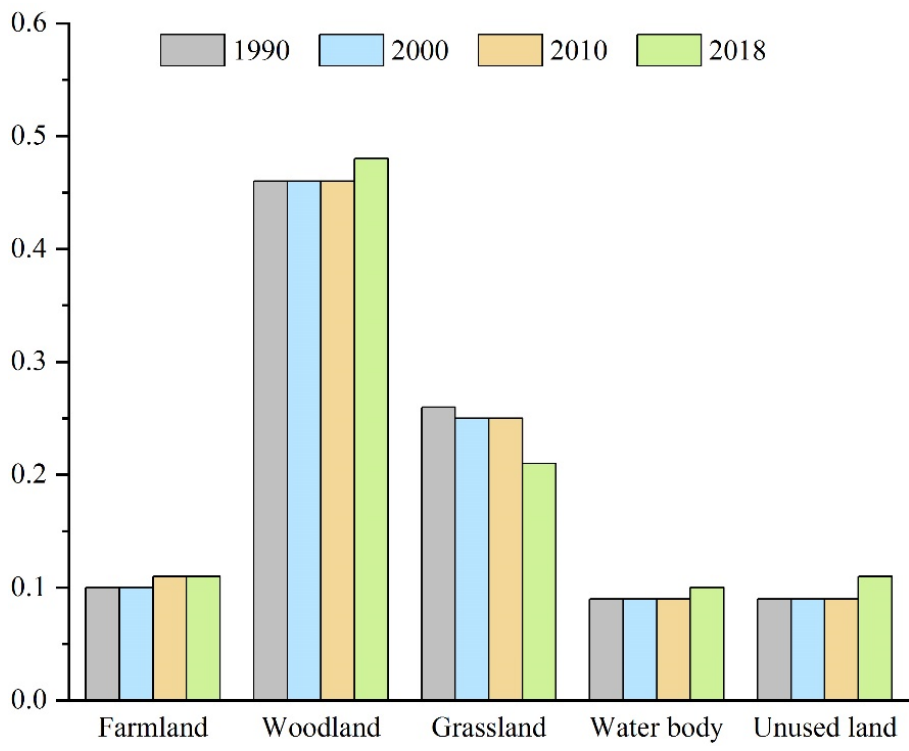
Figure 9. Sensitivity index of ESV.